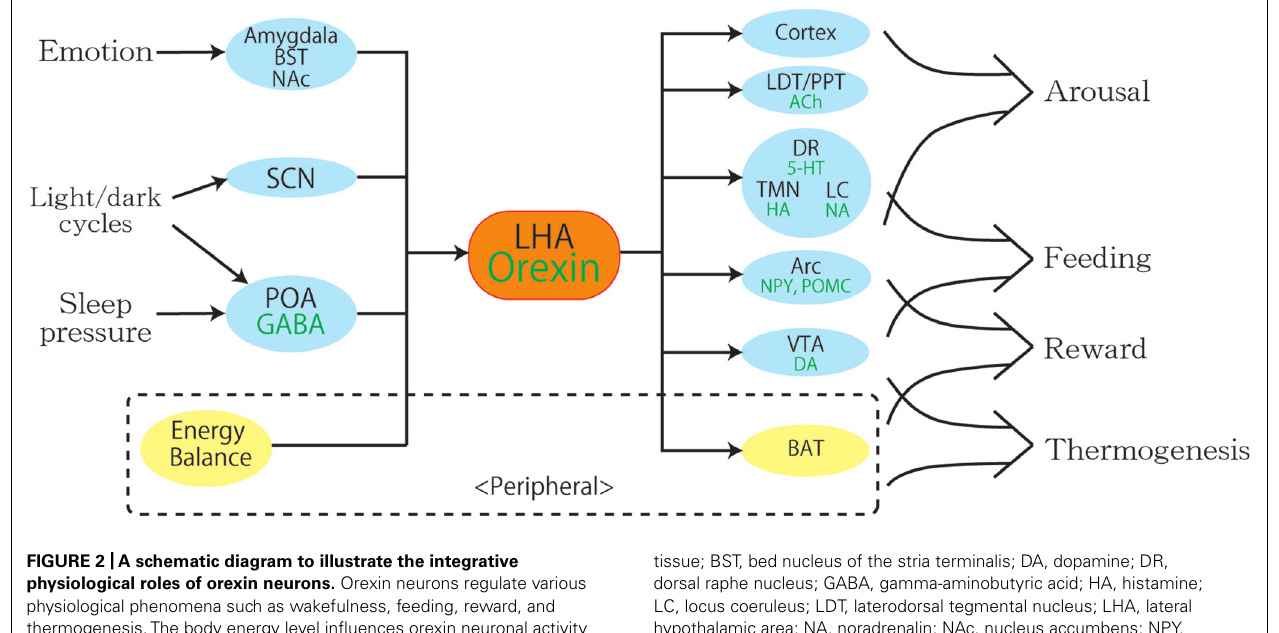
FIGURE 2 |A schematic diagram to illustrate the integrative physiological roles of orexin neurons. Orexin neurons regulate various physiological phenomena such as wakefulness, feeding, reward, and thermogenesis.The body energy level influences orexin neuronal activity to coordinate arousal and energy homeostasis. Inputs from the limbic system may be important to regulate the activity of orexin neurons to evoke emotional arousal or fear-related responses. Abbreviations: 5-HT, serotonin; ACh, acetylcholine; Arc, arcuate nucleus; BAT, brown adipose